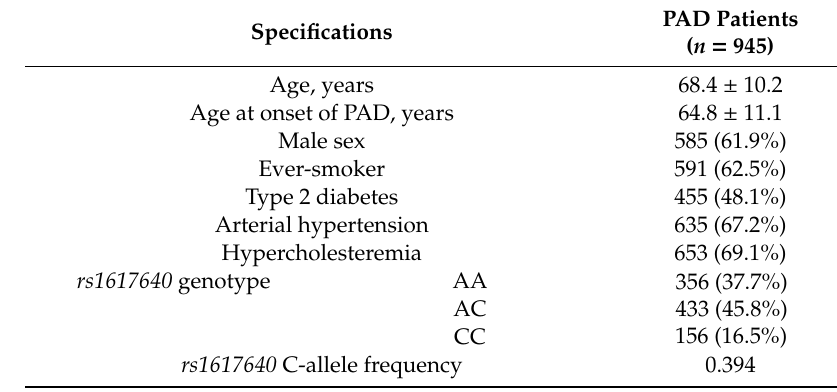
Table 1. Demographic and genetic data of peripheral arterial disease (PAD) patients. Age is presented as mean ± standard deviation, all other data are number of subjects (%).